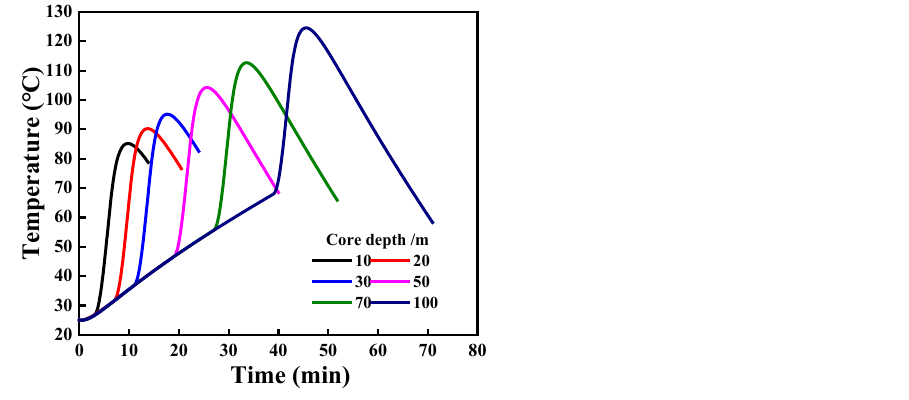
Figure 17. Temperature variation law of temperature measuring point at different core depths in GHS.